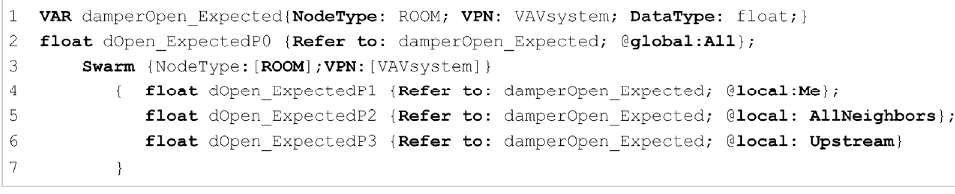
Figure A3. Sample code for defining parameters and computational scopes.